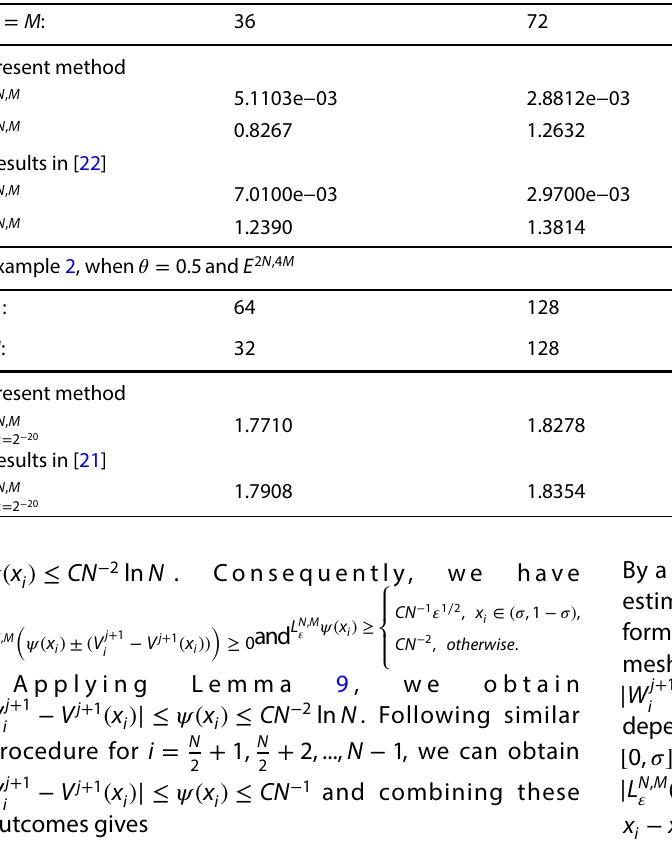
Table 3 Comparisons of the present method with other results in literature Example 1, when 𝜃 = 0.5 and T = 1 N = M